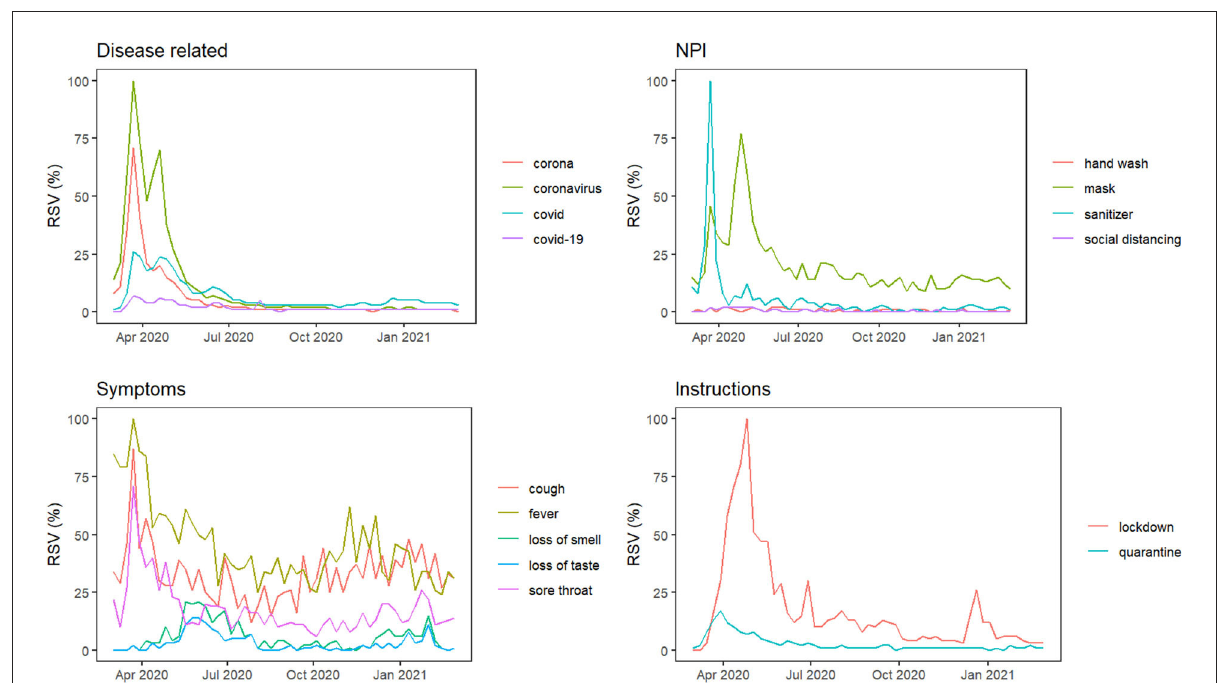
FIGURE1 Time plot of weekly GT RSVs for some COVID-19-related search terms in Nigeria. GT RSVs, Google Trends Relative Search Volumes; NPI, Non-pharmaceutical